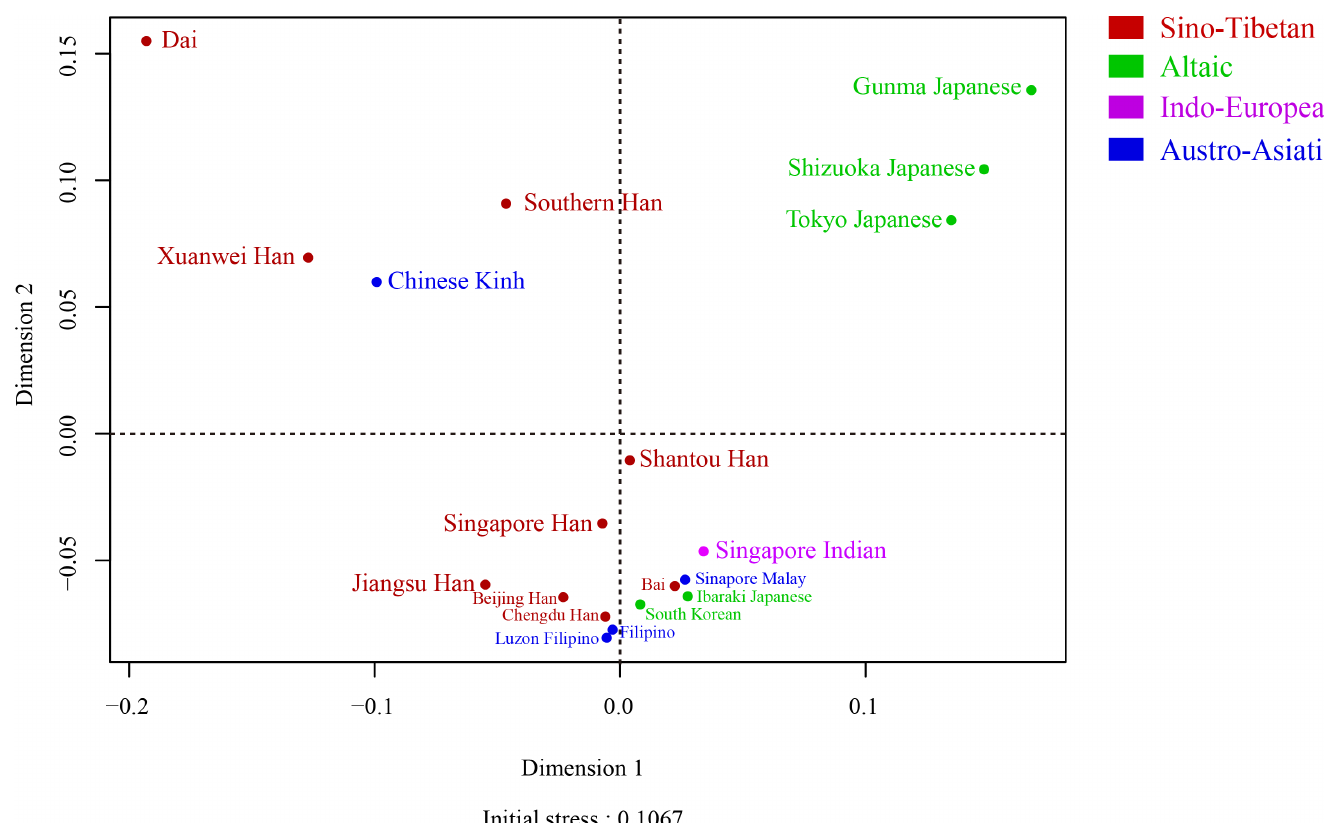
Fig 6. A Multi-Dimensional Scaling (MDS) plot constructed according to the RST genetic distance matrix among Jiangsu Han populations and other 18 populations in East Asia scale. The initial stress was 0.1067. The languageaffiliationsof these 19 populationswere also indicatedin different colors (Red: Sino-Tibetan; Green: Altaic; Purple: Indo-European; Blue: Austro-Asiatic).